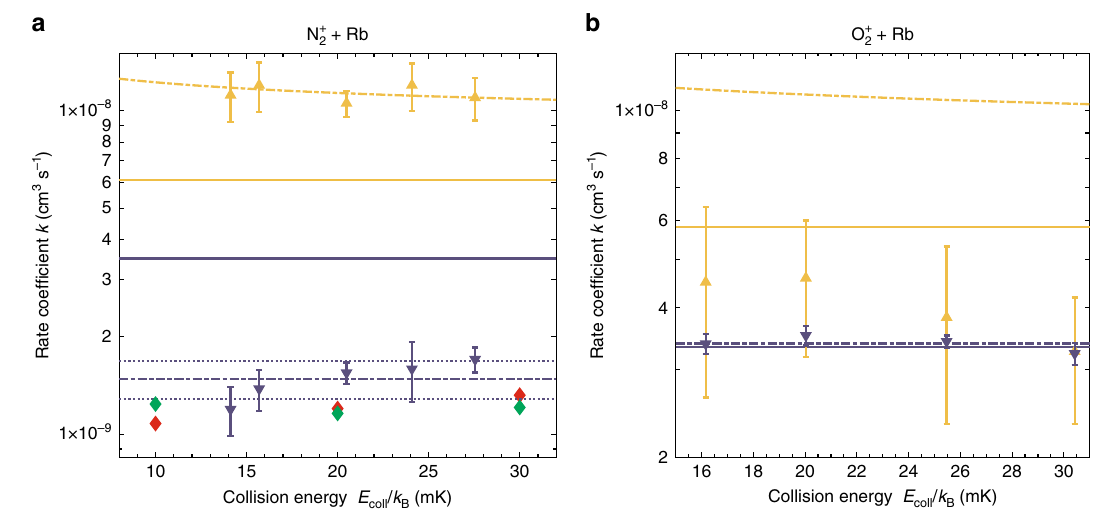
Fig. 3 Collision-energy dependent charge-transfer (CT) rate coef fi cients. Reaction rate coef fi cients as a function of collision energy and state of Rb for + Rb and b O þ + Rb. Blue [orange] symbols indicate CT rate coef fi cients for collisions with Rb in its 2 S 2 P a N þ 1 = 2 [ 3 = 2 ] state. The theoretical Langevin rate 2 2 coef fi cients for collisions in these channels are the blue [orange] solid lines. Dash-dotted lines represent fi ts to the experimental data, except for the orange dash-dotted line in b which represents the prediction of the rate coef fi cient for dominant ion-quadrupole capture. The red and green diamonds in þ Rb ( 2 S a represent CT rate coef fi cients for N þ 1 = 2 ) computed by quasiclassical trajectory simulations and quantum scattering calculations, respectively. 2 Error bars represent one standard molecular bond length r . The curves for the relevant cationic ground states are the solid green lines. Solid blue lines indicate the cationic curves shifted by the ionisation potential of Rb which correspond to the relevant energies of the lowest entrance channels for the CT reaction. The dashed lines represent the same ) state. curves offset by the energy of excitation to the Rb ( 2 P 3 = 2 The potential curves shown are cuts through the three- dimensional PES of the collision system with the Rb moiety at an in fi nitely large distance from the molecule. Curve crossings (indicated by circles) between the shifted ionic and neutral curves appear close to the molecular equilibrium geometry in both therefore CT around the crossing points.